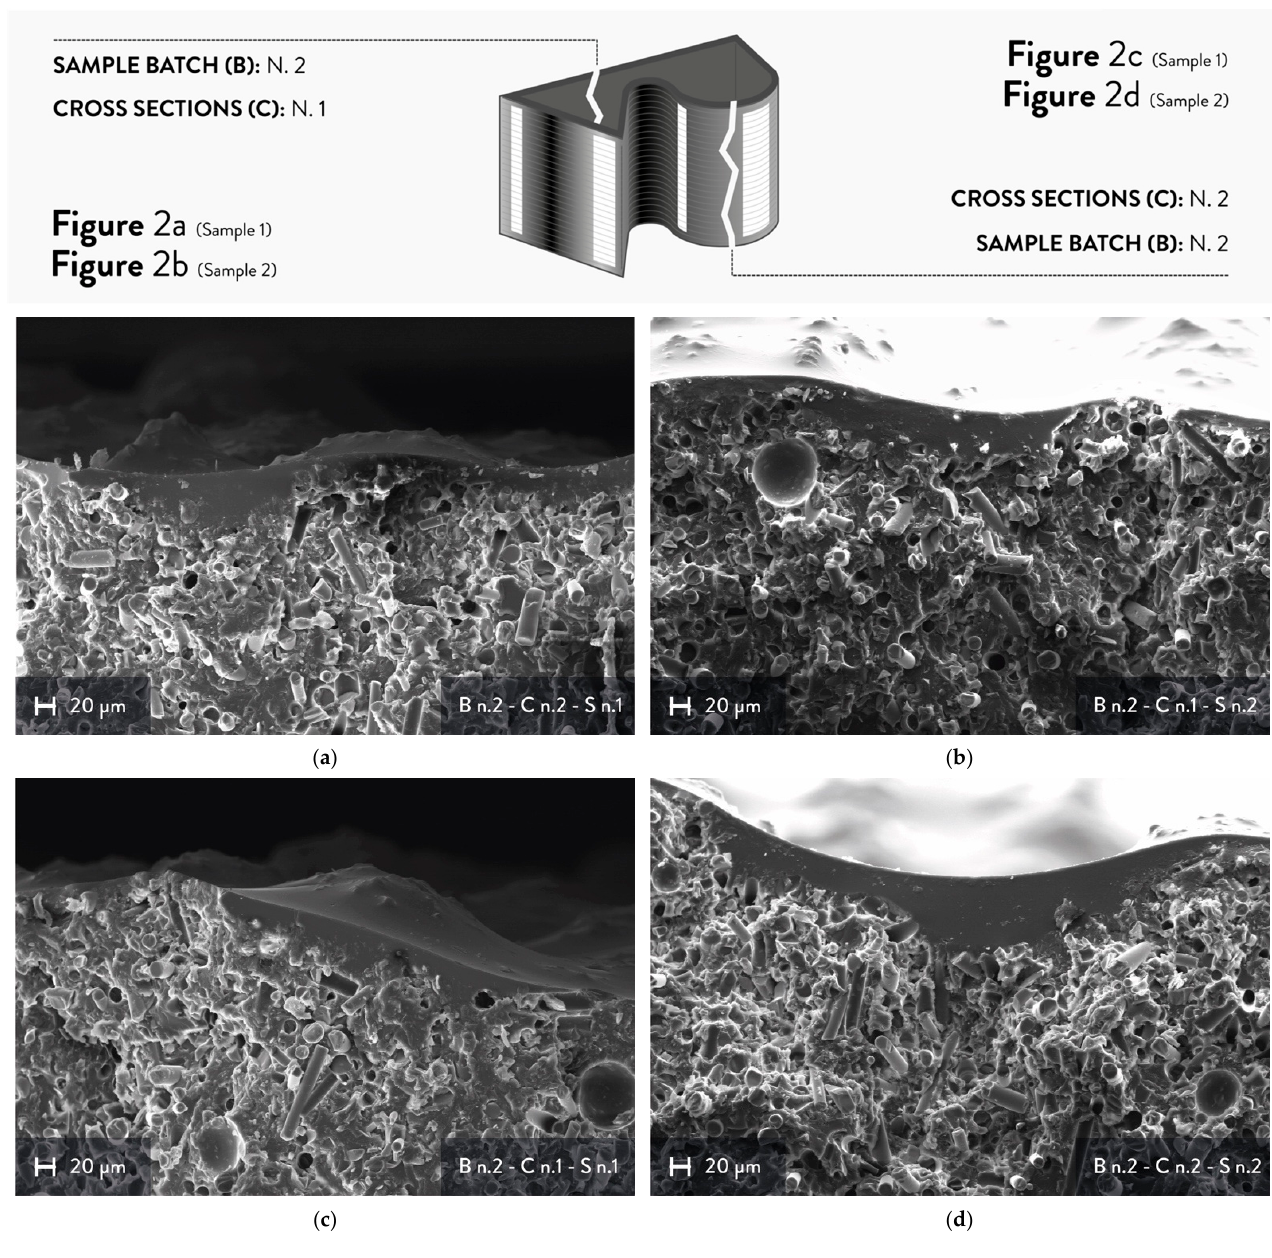
Figure 2. SEM micrographs of cross ‐ sections from batch n. 2 (500× magnification): ( a ) cross ‐ section